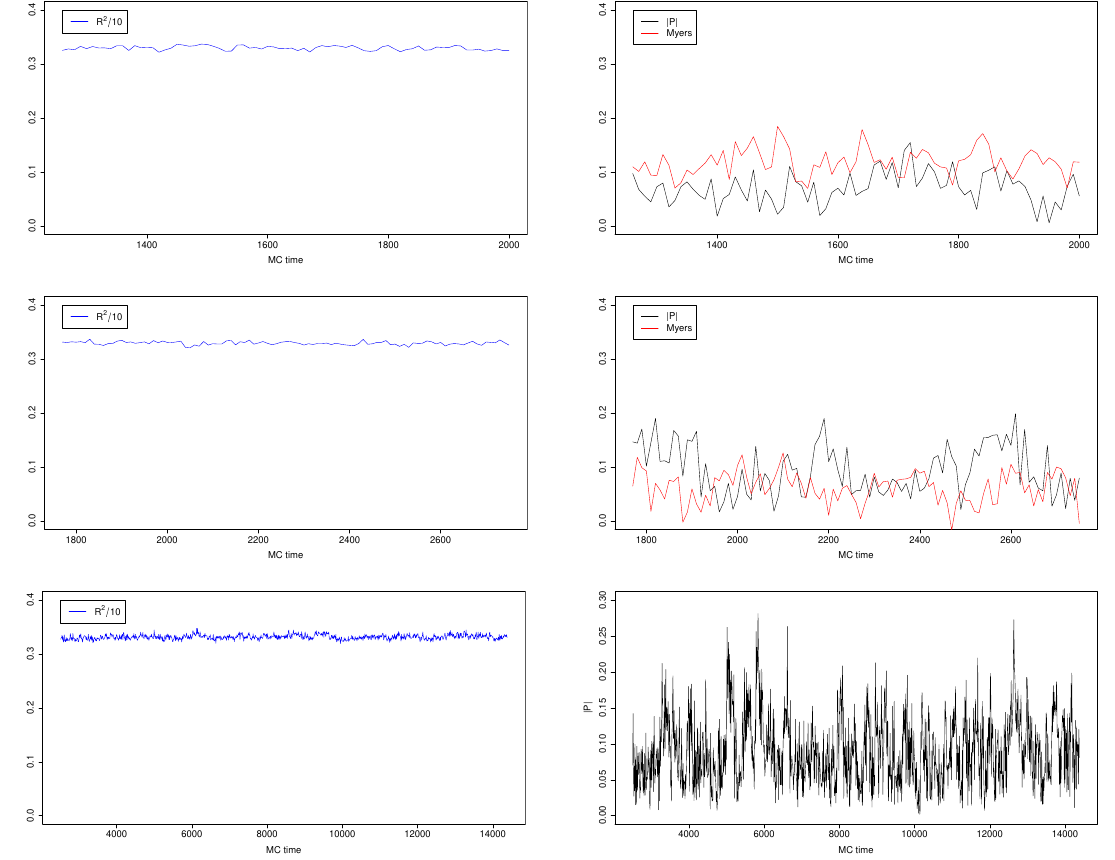
Figure 26. Monte Carlo histories showing confined, stable states for N = 12 , L = 48 and temper- ature T = 0 . 2 . From first row to third we have µ = 0 . 2 , 0 . 1 , and µ = 0 respectively. No constraint was imposed for the simulation.